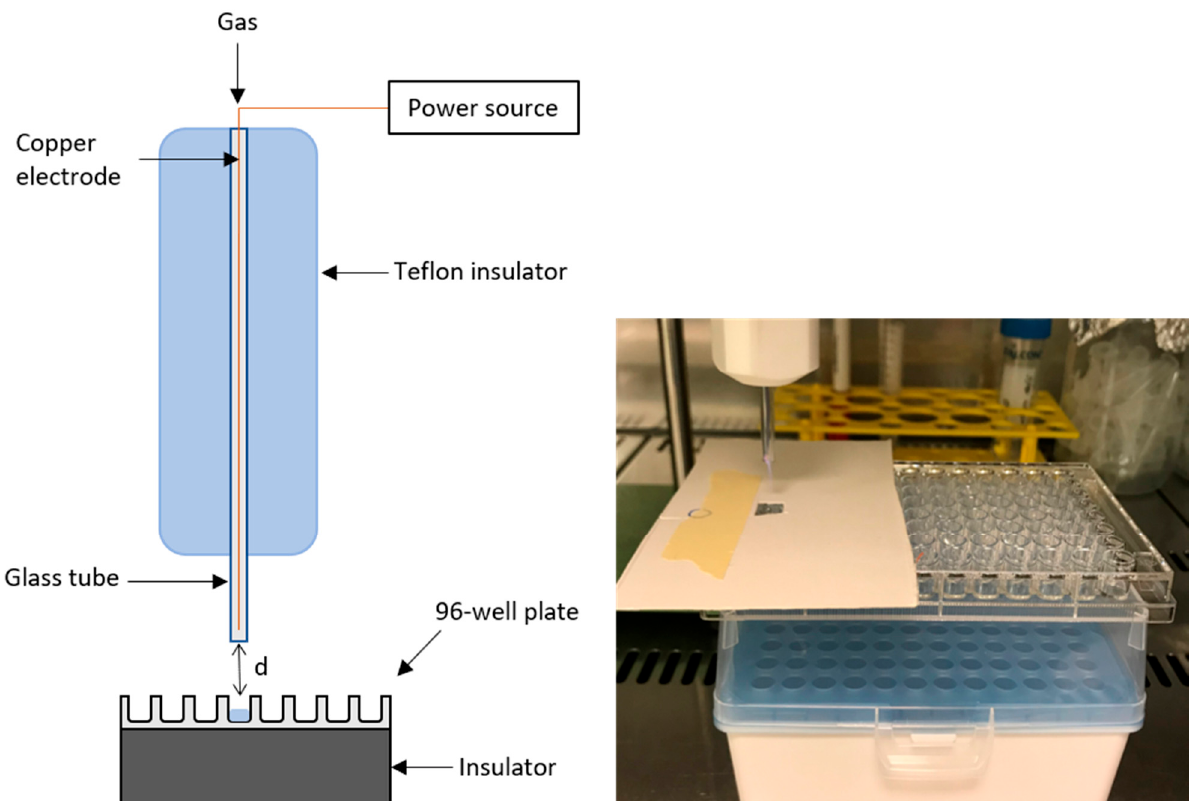
Figure 1. Schematic representation ( left ) and photograph ( right ) of the simple plasma jet system and setup for an in vitro cell treatment.